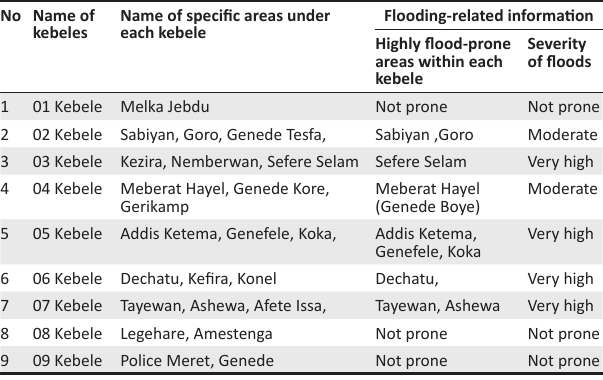
TABLE 2: A description of the selected kebeles that are susceptible to flooding in Dire Dawa. No Name of Name of specific areas under kebeles each